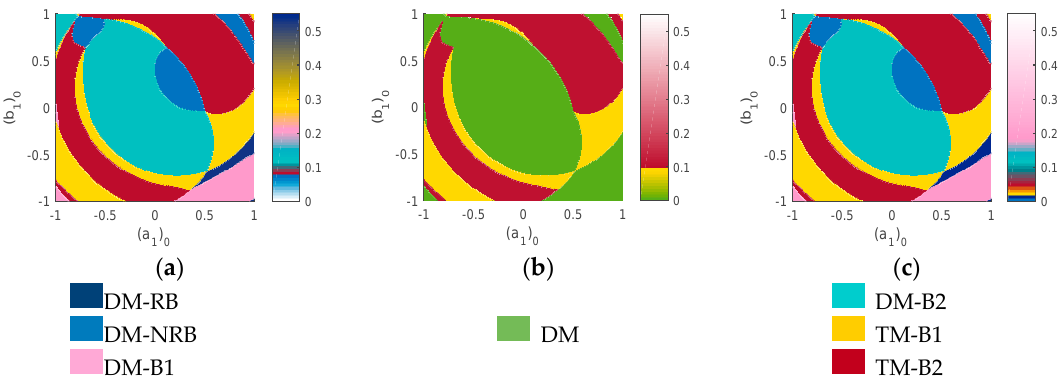
Figure 12. Basins of attraction of the deterministic amplitudes ( a ) |(cid:1827) (cid:2869) | (cid:2870) , ( b ) |(cid:1827) (cid:2870) | (cid:2870) and ( c ) |(cid:1827) (cid:2871) | (cid:2870) in the Nyquist plane (((cid:1853) (cid:2869) ) (cid:2868) , ((cid:1854) (cid:2869) ) (cid:2868) ) for (cid:2026) = −1 , ((cid:1853) (cid:2870) ) (cid:2868) = ((cid:1854) (cid:2870) ) (cid:2868) = 0.2 and ((cid:1853) (cid:2871) ) (cid:2868) = ((cid:1854) (cid:2871) ) (cid:2868) = 0.3 .